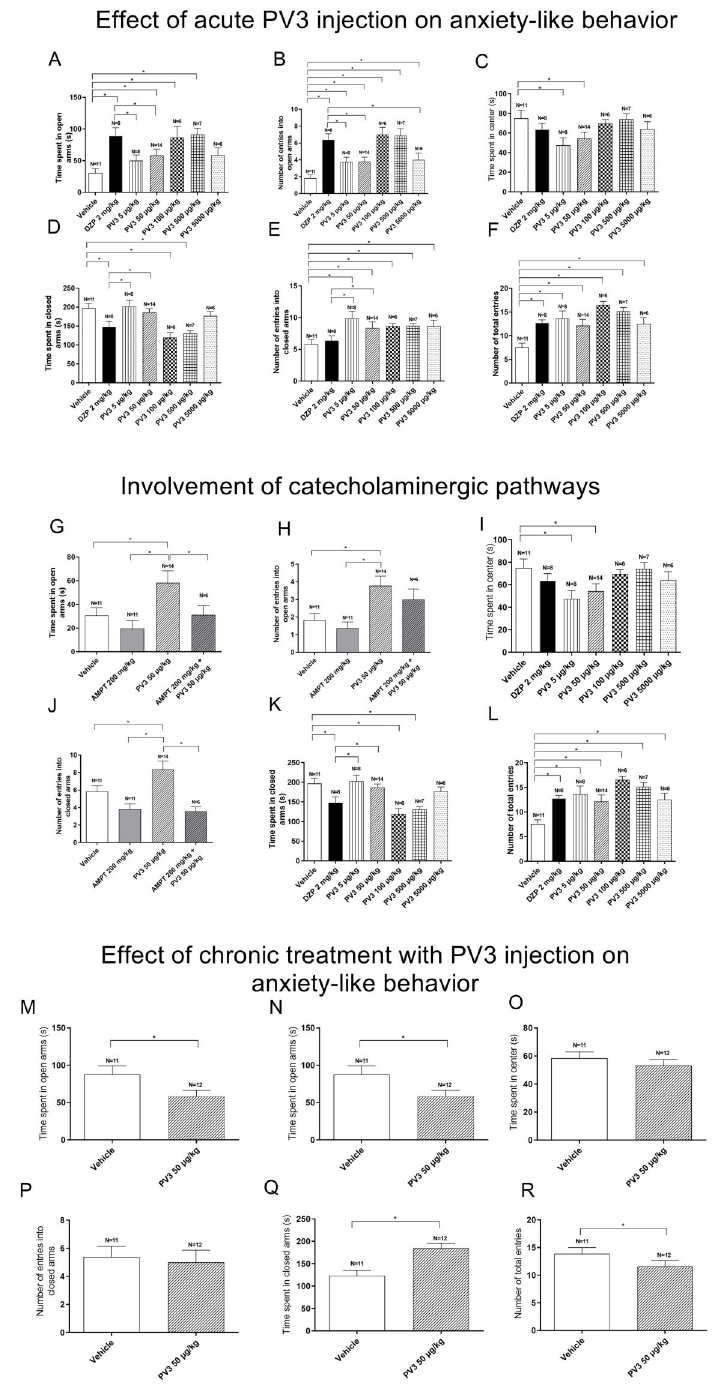
Figure 1. Effect of acute Phaseolus vulgaris peptide (PV3) injection on anxiety-like behavior of rats exposed to the elevated plus maze (panels A – F ). Involvement of catecholaminergic pathways (panels G – L ). Effect of the chronic treatment with PV3 (panels M – R ). *P o 0.05 (ANOVA or t